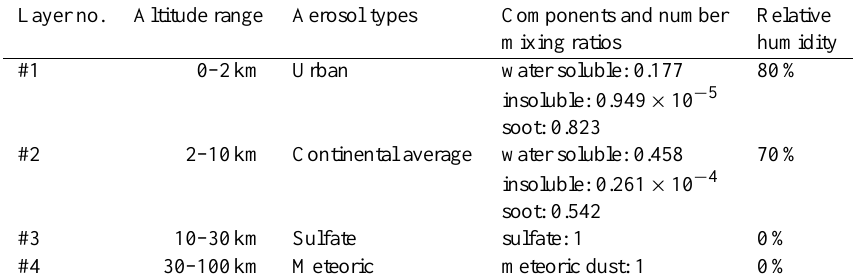
Figure 4. Vertical profiles of (a) NO 2 volume mixing ratio (VMR) and (b) NO 2 partial column density of each layer. Tropospheric (0–10km) total column density is 1.1 × 10 16 [cm − 2 ].